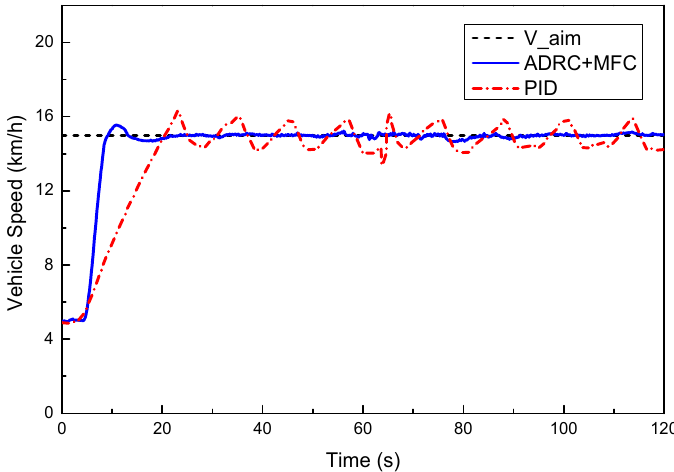
Figure 15. Longitudinal velocity tracking results on straight road.